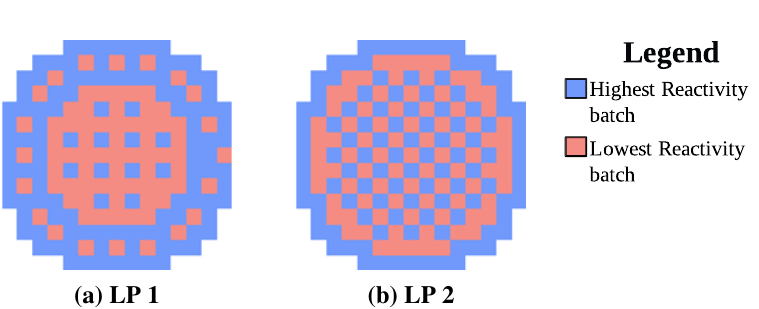
Figure 3: LP designs using SQA for a two fuel-type PWR.